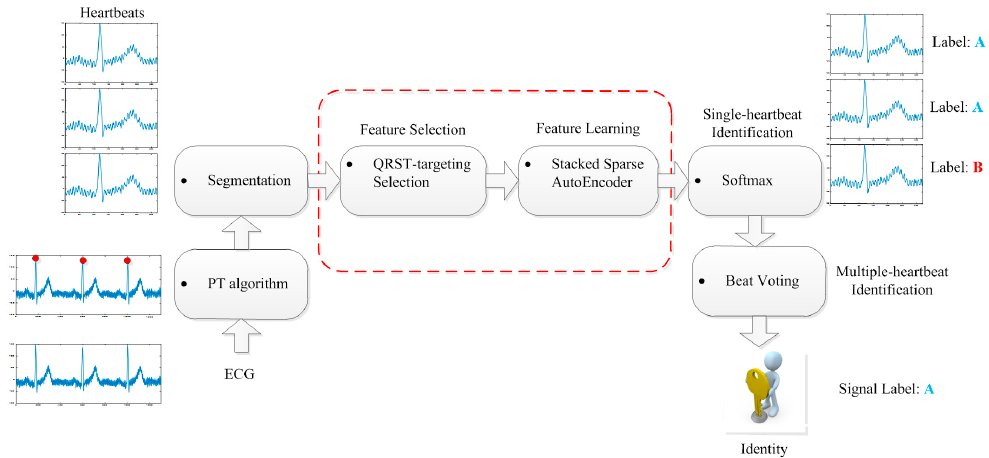
Figure 1. Diagram of the electrocardiogram (ECG) identification methodology proposed.